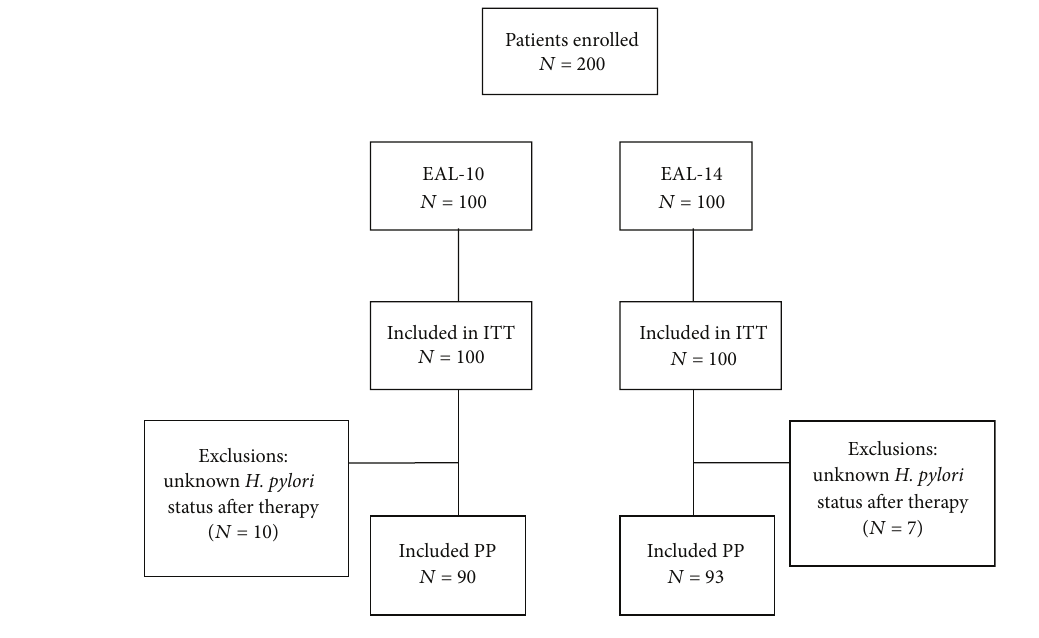
Figure 1: Disposition of patients.